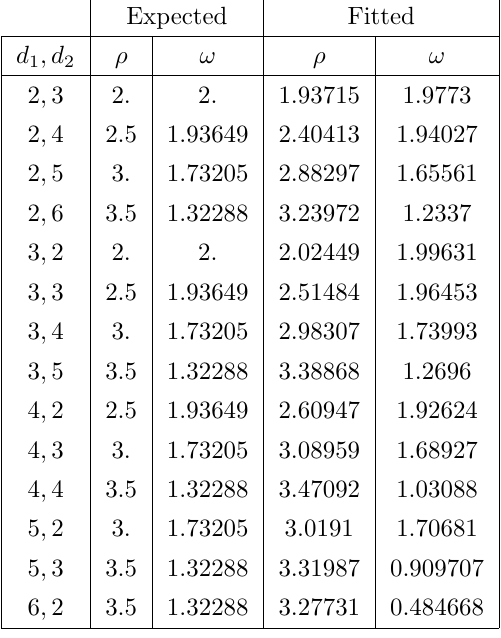
Table 1 . Fitted values for the complex exponent of (cid:12) ( r 0 ) vs the analytical